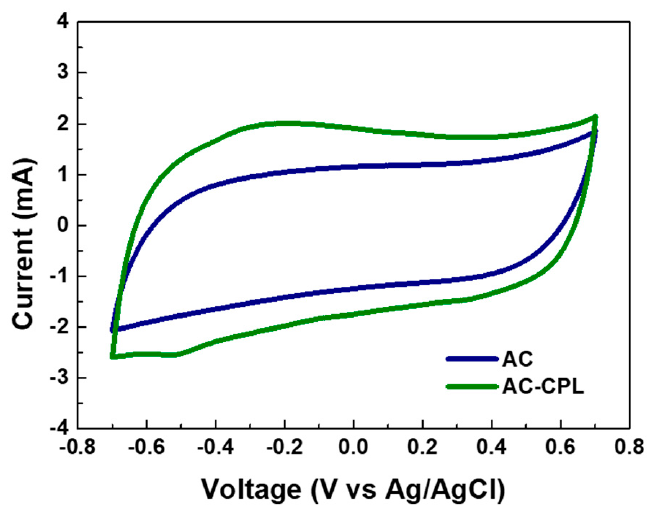
Figure 3. Comparison of cyclic voltammetry curves of AC and AC-CPL in 0.5 M CsNO 3 at 2 mV s − 1 scan rate.